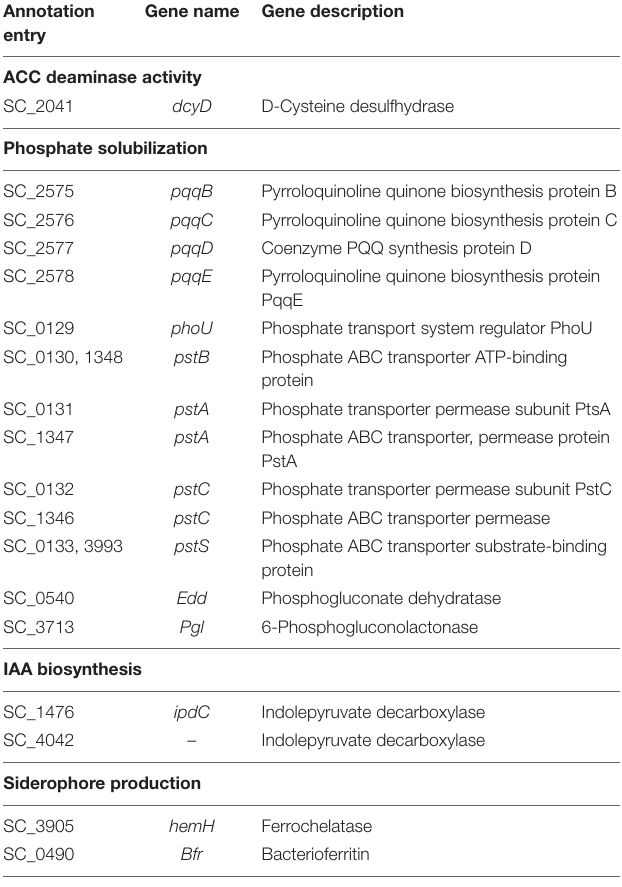
TABLE 3 | Major genes related to plant growth-promoting effects of JW-CZ2.